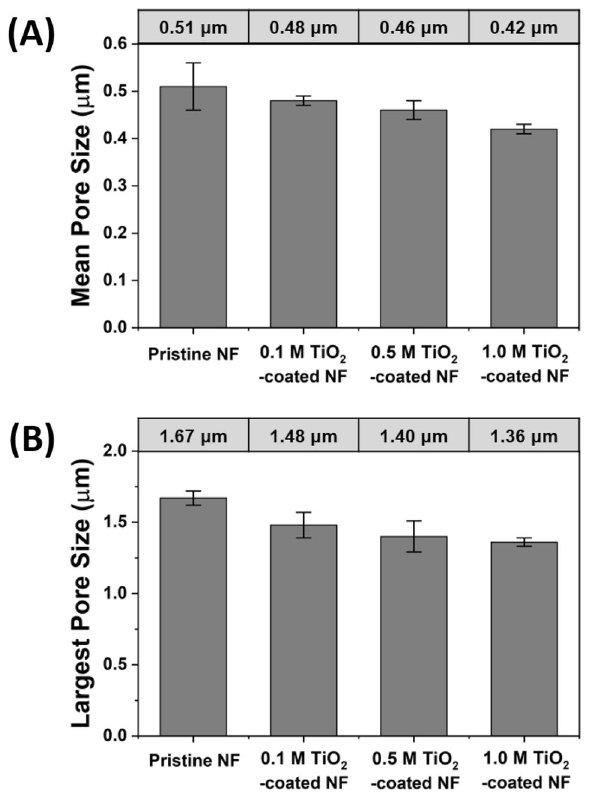
Figure 5. CFP of YSZ/silica (pristine) and TiO 2 -coated YSZ/silica NF. ( A ) The mean pore size and ( B ) the largest pore sizes were measured at the concentration of TiO 2 (0, 0.1, 0.5, and 1.0 M).